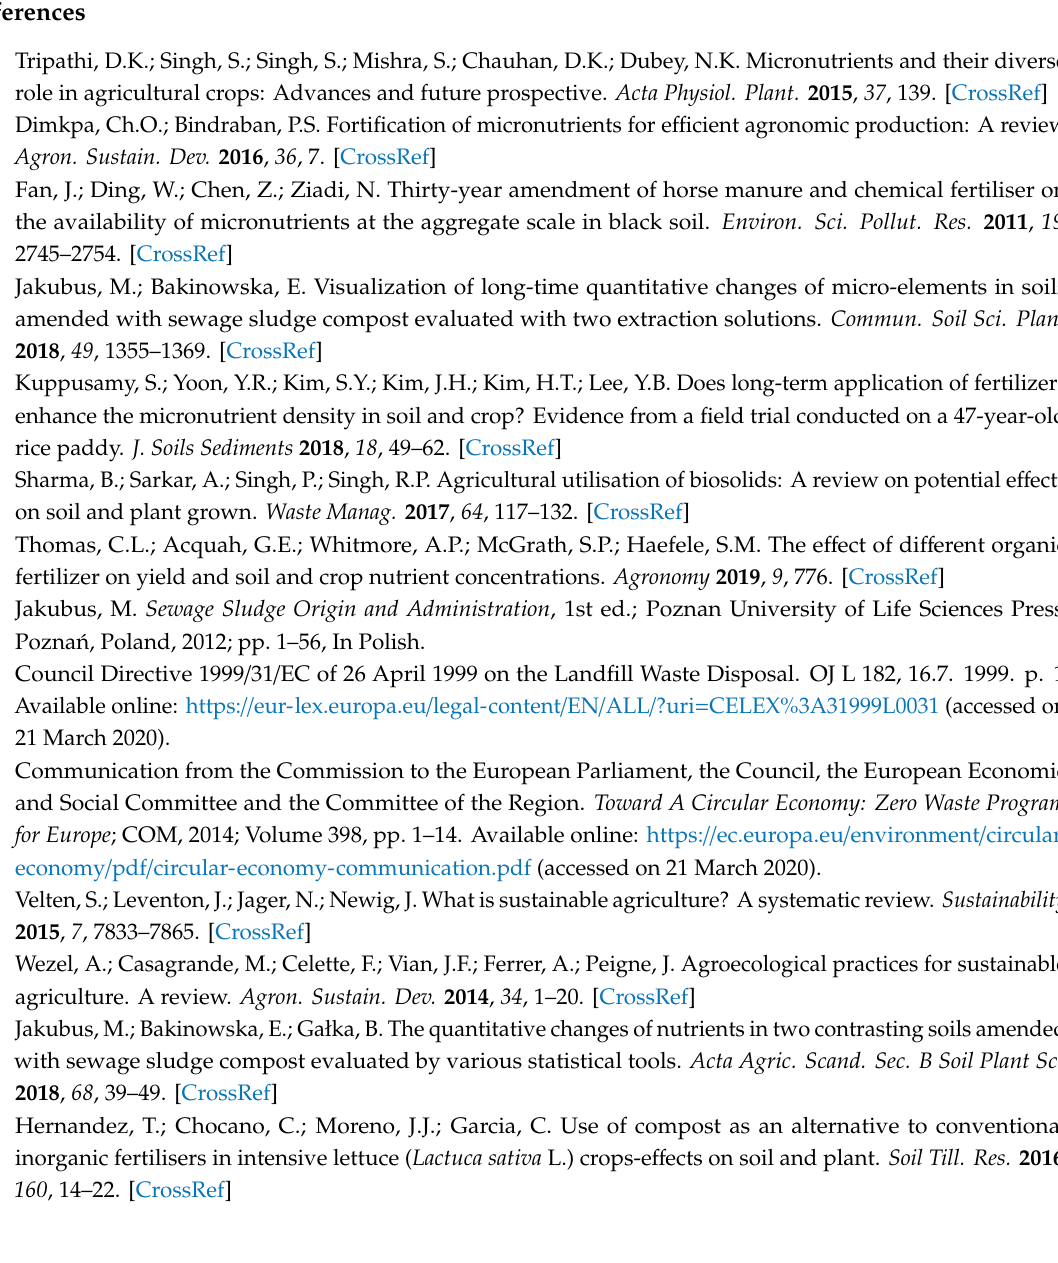
Figure S1. Climate graphs characterizing weather conditions in